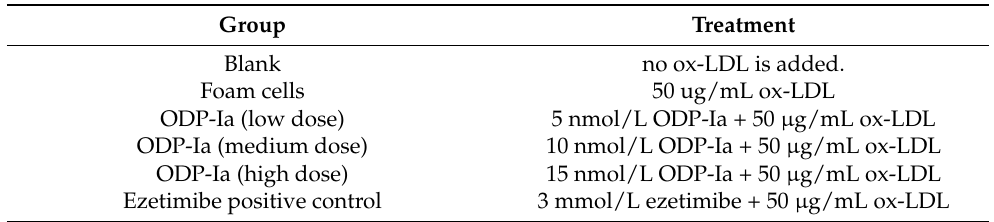
Table 1. Groups of the effect of ODP-Ia on the cholesterol efflux-associated gene expression in foam cells. Group Treatment